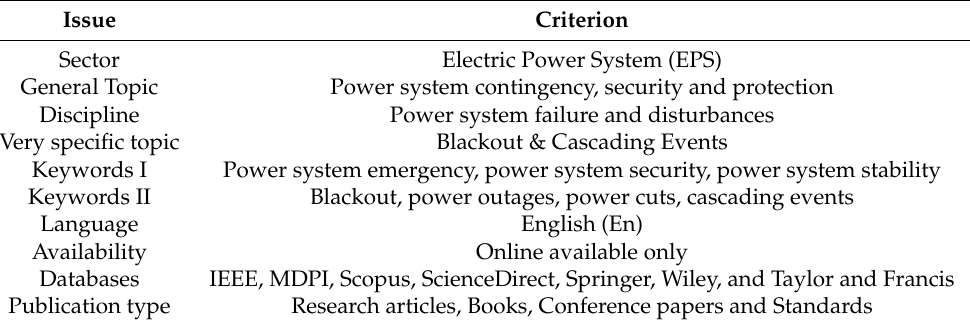
Table 1. Terms and searched databases used in the review methodology.